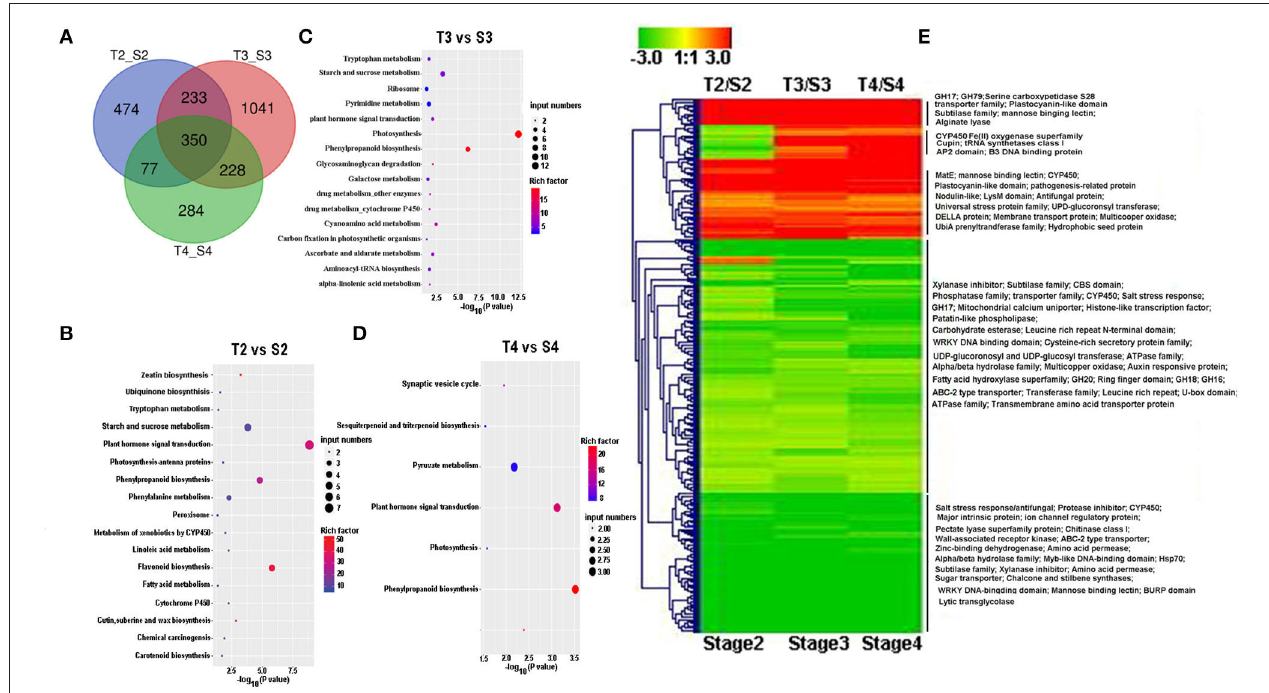
FIGURE 5 | Heatmp showing the differentially expressed genes (DEGs) between symbiotic germination at the same stage during D. offcinale inoculated with Tulasnella sp. (S6) and Serendipita sp. (12825). (A) The number of DEGs when D. officinale seed inoculated with Tulasnella sp. compared to with Serendipita sp. at the same development stage; (B–D) KEGG enrichment analysis of up-regulated DEGs at various germination stages during D.officinale symbiotic germination with two fungi. (E) Heatmap showing the expression pattern of 350 common differentially expressed genes in D. officinale × Tulasnella sp. compared to D. officinale × Serendipita sp. Expression value was calculated based on Log2 Fold change, red color means up-regulated expression and green color means down-regulated expression. S2, S3, and S4 mean stages 2, 3, and 4 in symbiotic germination with Serendipita sp., respectively, T2, T3, and T4 mean stages 2, 3, and 4 in symbiotic germination with Tulasnella sp.,